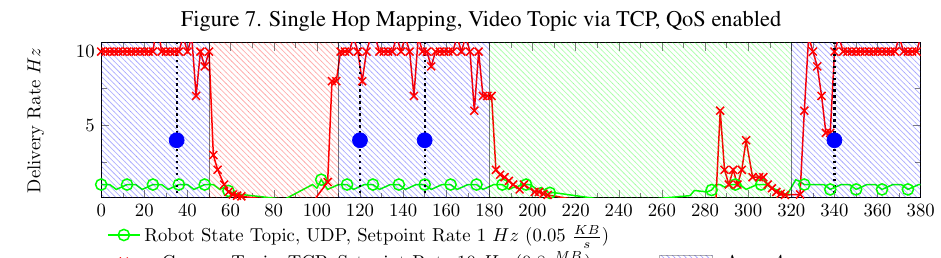
Figure 7. Single Hop Mapping, Video Topic via TCP, QoS enabled